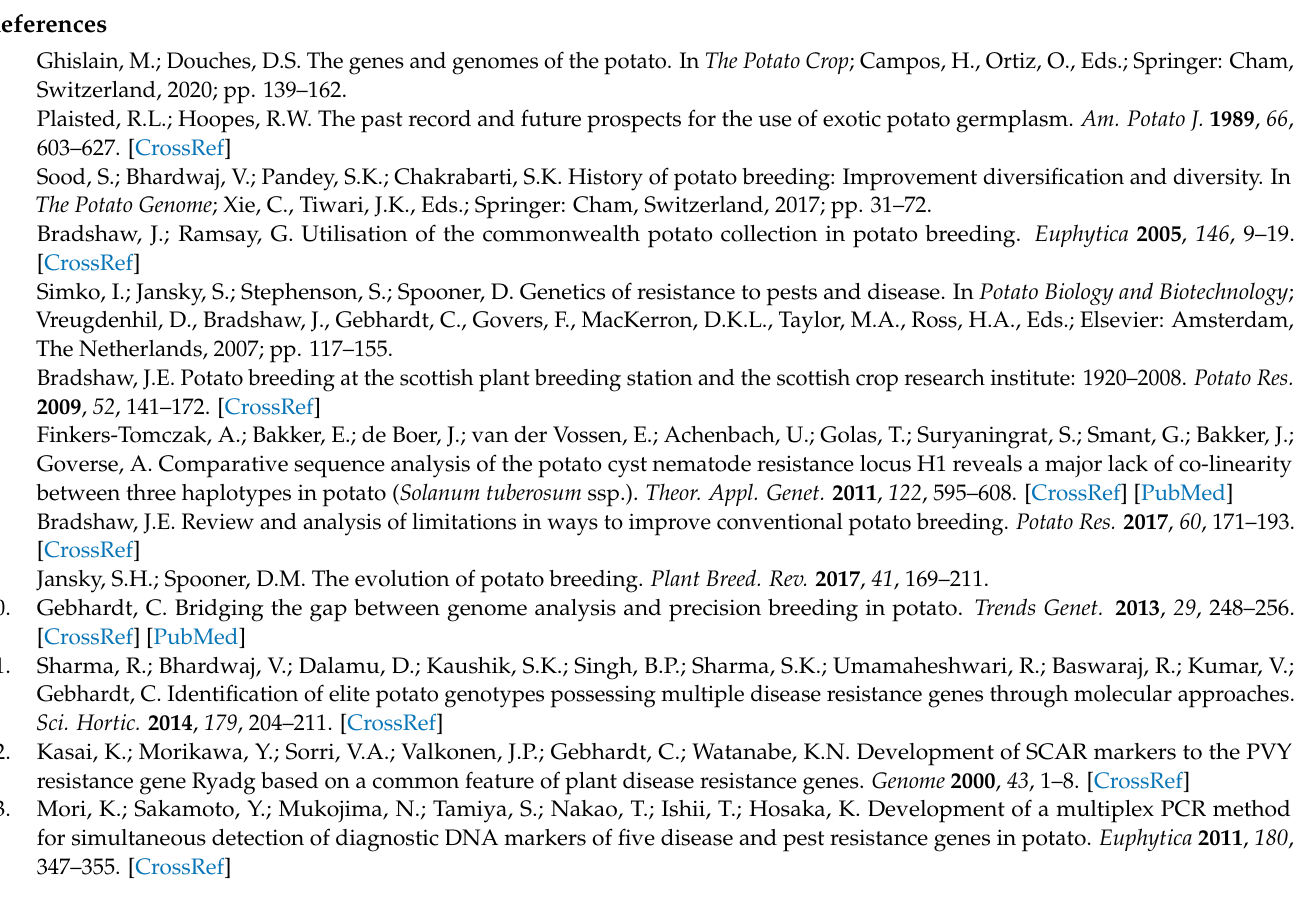
somes, Figure S2: Distribution of deletions and insertions on potato chromosomes (a) identified by Sniffles; (b) identified by SVIM, Figure S3: Sequencing depth and gene distribution per chromosome, Table S1: List of structural variants containing a few genes found in Alaska, Argo and